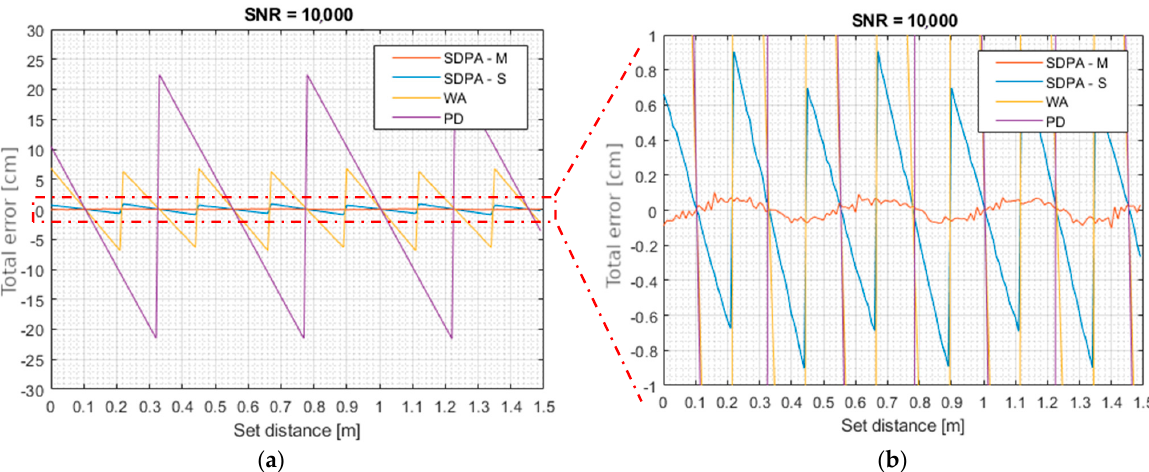
Figure 6. Simulation results. ( a ) Total error Δ s of simulated measurements, ( b ) Detailed plot of results of simple and modified approximation algorithms.